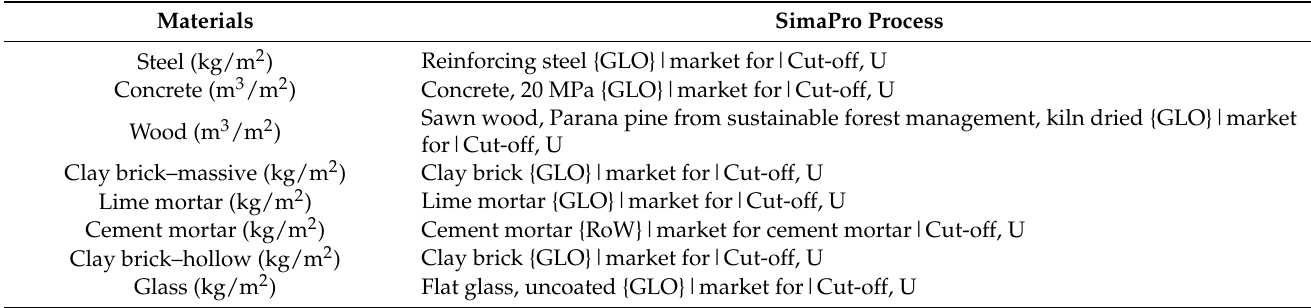
Table 2. Materials and SimaPro processes.